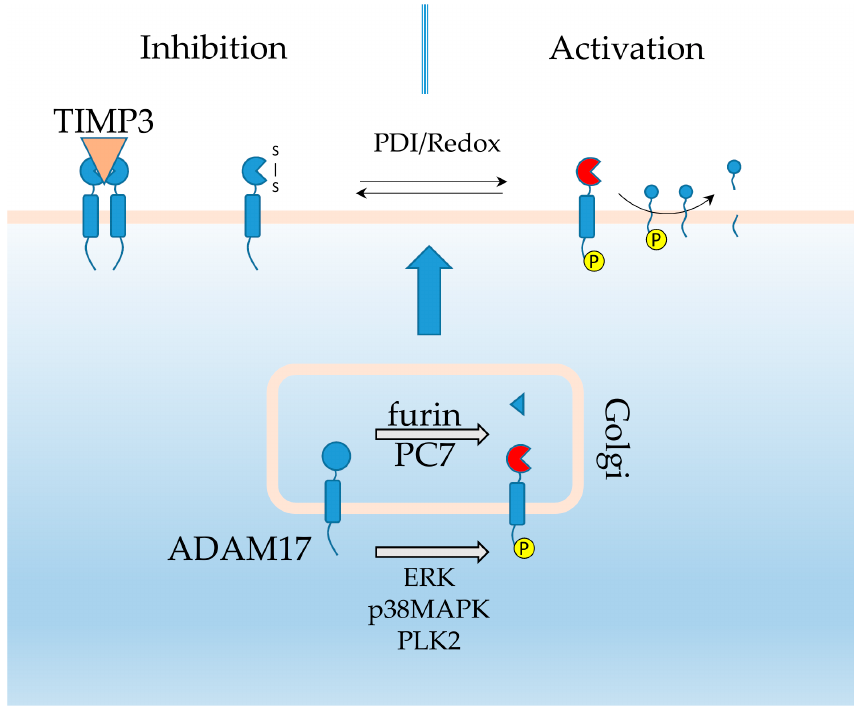
Figure 1. ADAM17 post translational regulation. ADAM17 is processed in the Golgi to remove its inhibitory pro-domain. Its cytoplasmic tail is phosphorylated, but that is not required for its transport from the Golgi to the cell surface. However, when not phosphorylated this induces ADAM17 dimerization and TIMP3 binding resulting in inactivation. Alteration in the disulfide bridge arrangements can also alter ADAM17 ′ s activation status. The phosphorylation status of the substrates themselves can also alter ADAM17 shedding performance.